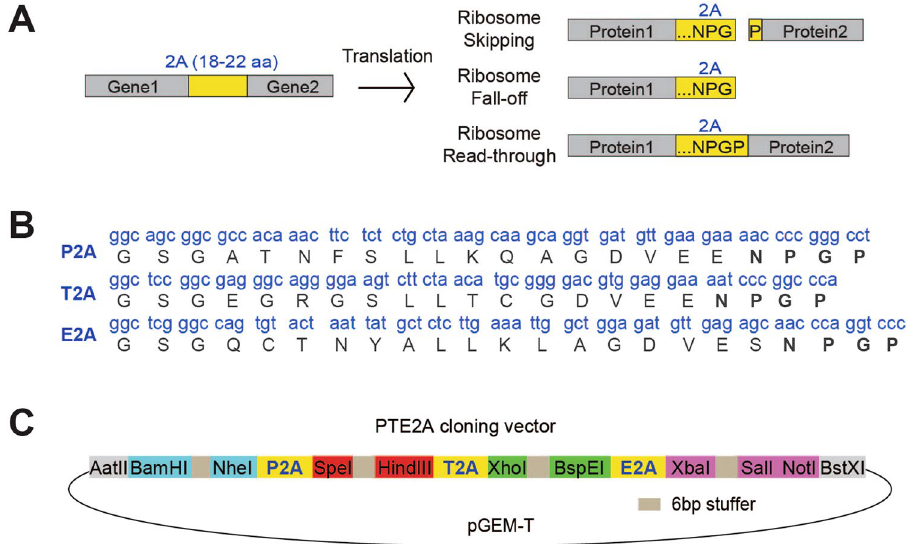
Figure 1. Construction of the multi-gene co-expression vector with 2A sequences. ( A ) Schematic representation of the mechanism of “self-cleaving” 2A peptides. ( B ) DNA and amino acid sequences of the various 2As used. A GSG linker was added to the N-terminus of all 2As. ( C ) A simplified map of the pGEM-T- PTE2A cloning vector showing 2As and restriction sites